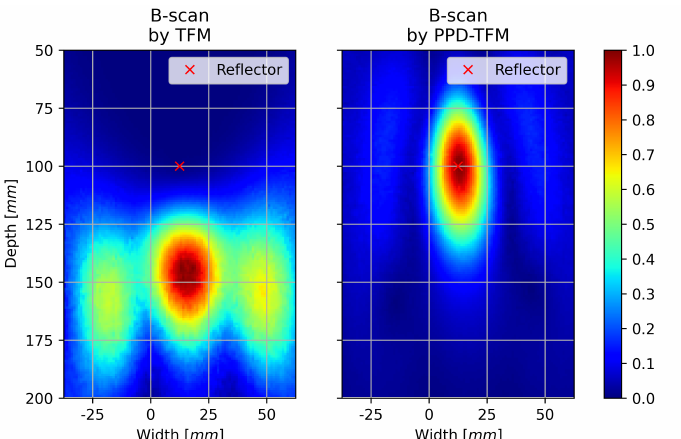
Figure 3. B-scan for Simulation by Total Focusing Method (TFM) ( left ) and Pulse Peak Delay—Total Focusing Method (PPD-TFM) ( right